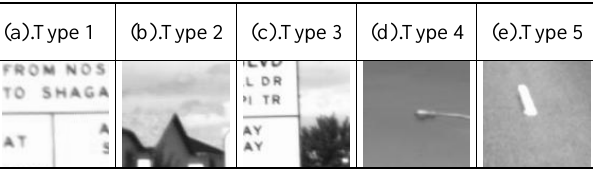
Figure 11. Examples of 5 categories of selected point features